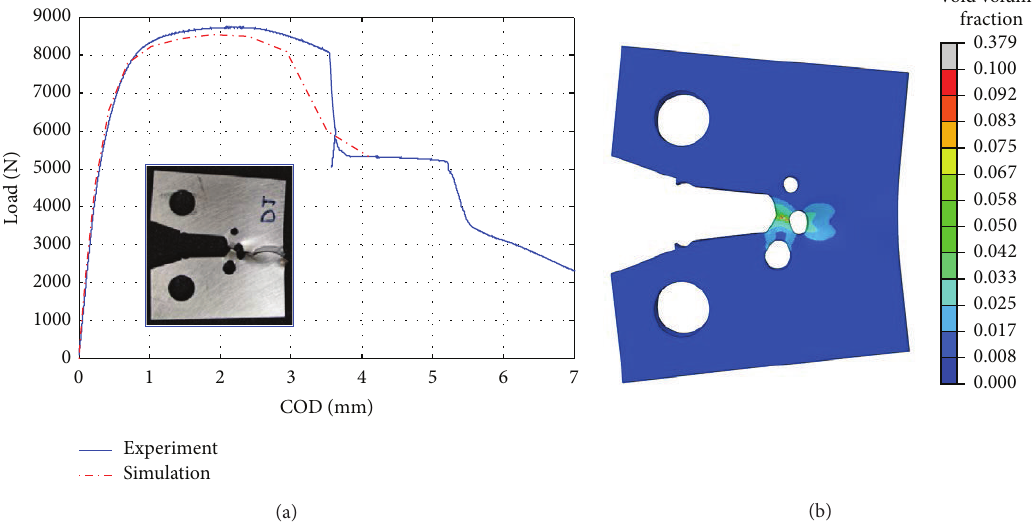
Figure 5: Experimental and simulated load versus COD profiles for D1 specimen, (a). The contour of void volume fraction, showing void accumulation along ligament A-C, taken at load = 5,333 N, (b). Photograph of specimen adapted from